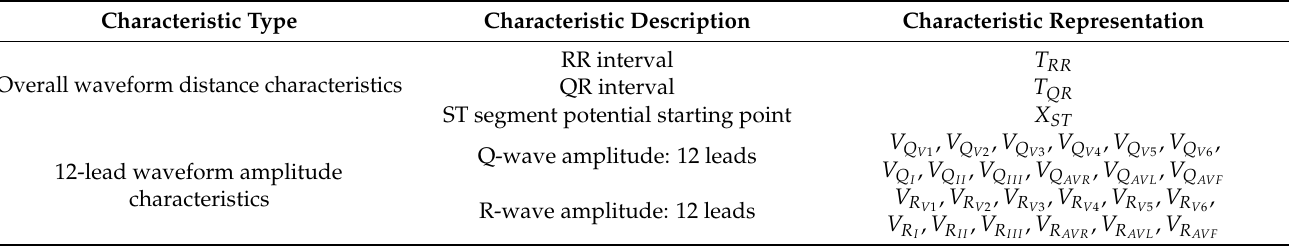
Table 3. Description of feature extraction.